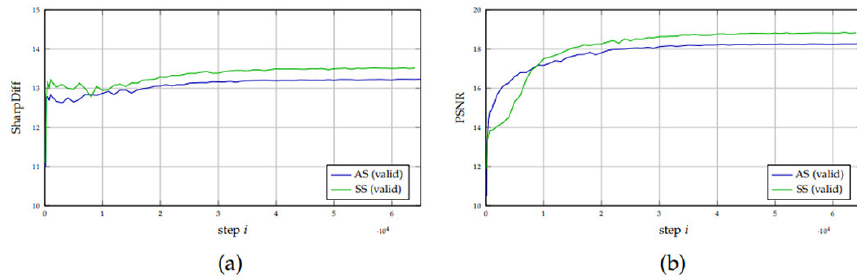
Fig. 9. Comparison of validation results based on a model either using the scheduled sampling or the always sampling training technique